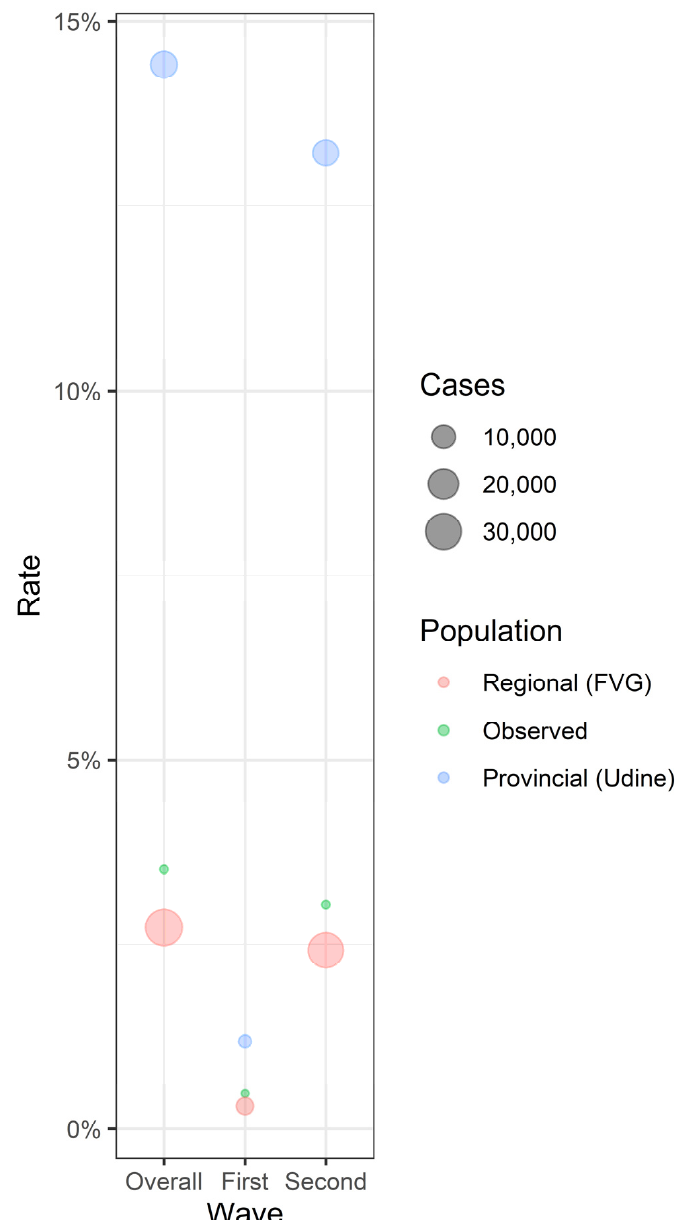
Figure 1. Rate of COVID-19 positive cases across regional (red), provincial (blue), and observed (green) cases, reported overall and stratified by waves.